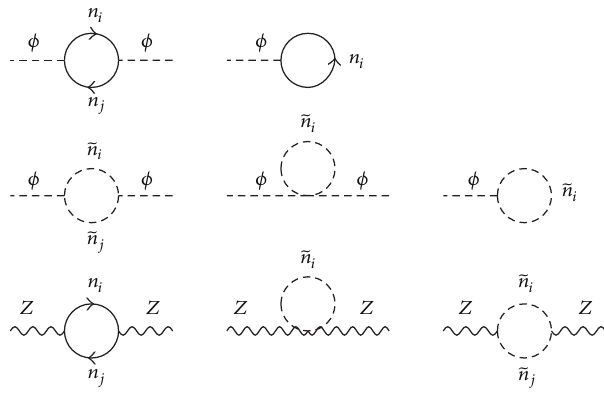
Figure 1: Generic one-loop Feynman-diagrams contributing to the computation of the one-loop new corrections to the Higgs boson mass form neutrinos and sneutrinos. Here 𝜙 = ℎ, 𝐻,𝐴